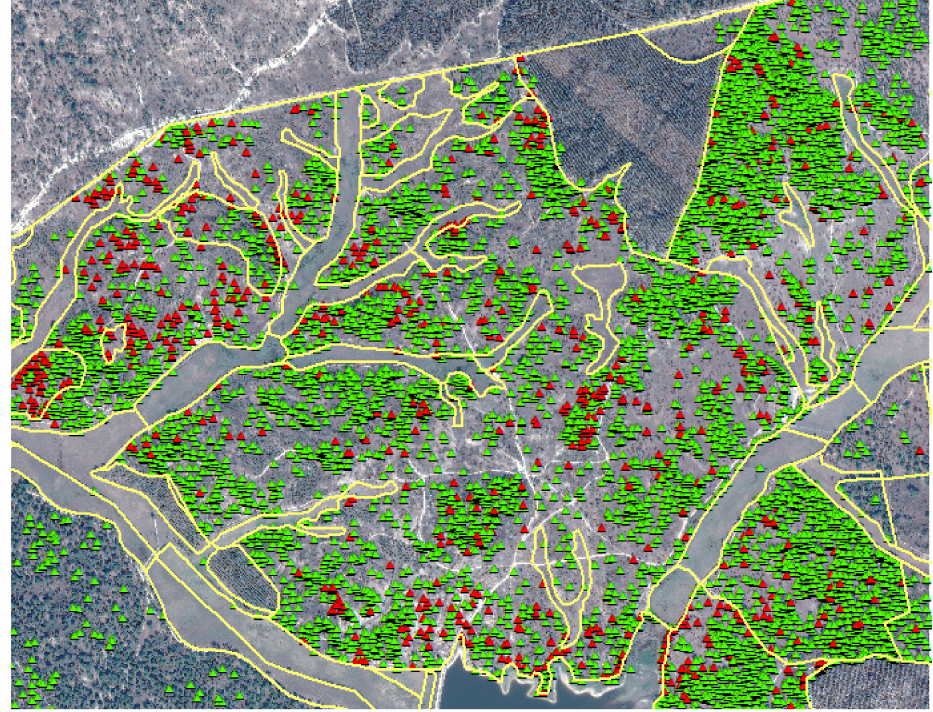
Figure 8. Results of the multitemporal tree classification for the study area. Red triangles represent dead trees and green triangles represent healthy trees, superimposed on the Pleiades